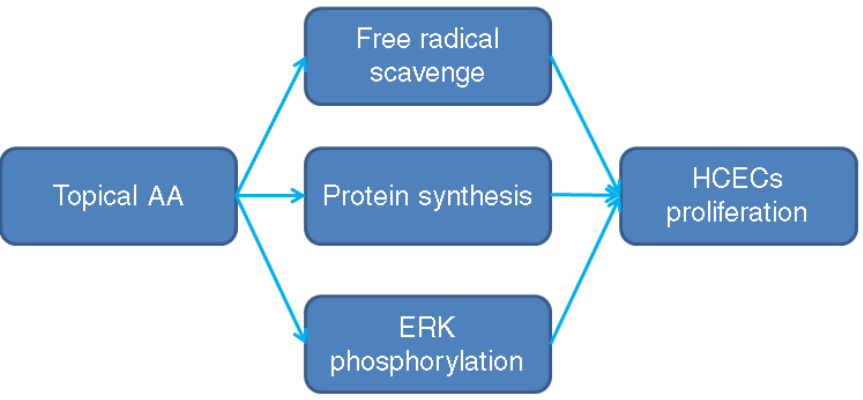
Figure 6. The possible mechanism of ascorbic acid on human corneal endothelial cell proliferation. AA: ascorbic acid, HCEC: human corneal endothelial cells, ERK: extracellular signal-regulated kinases.